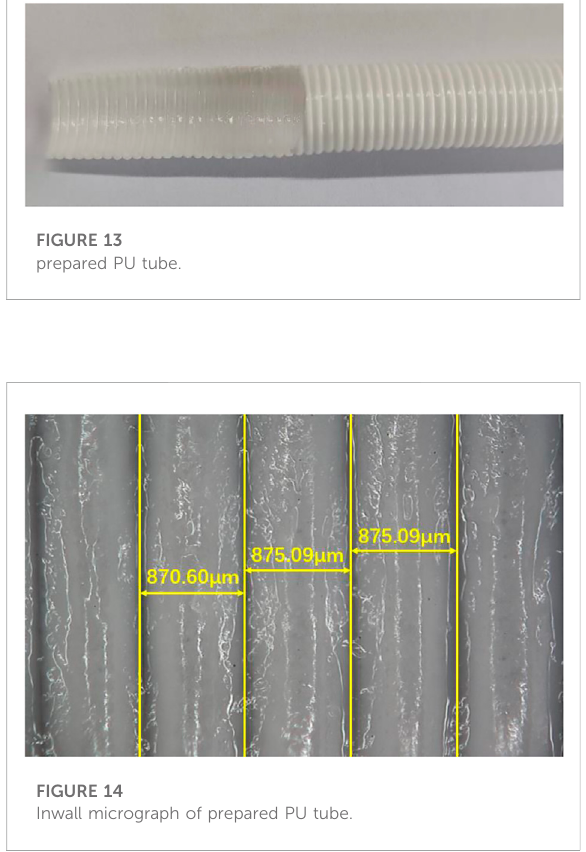
TABLE 4 Measured results of fi lament diameter and included angle.